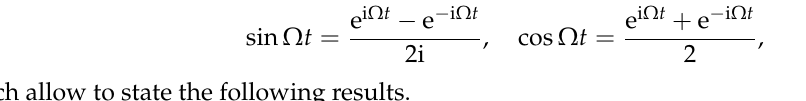
e Ω t and C D α e Ω t with Ω α e Ω t for α = 1.7 and Ω = − 0.5 + 0 0